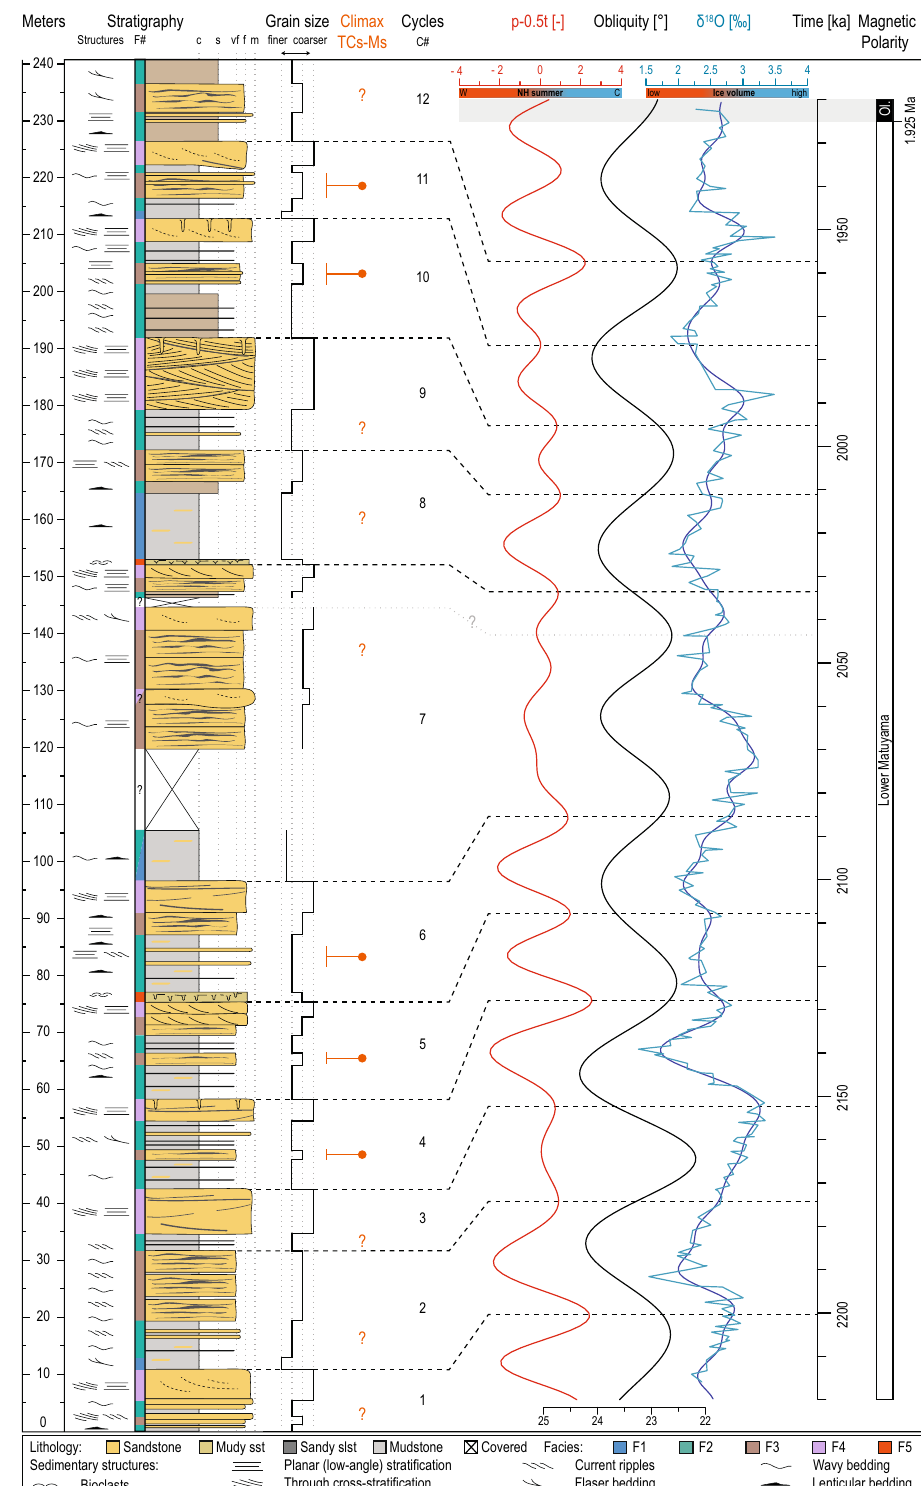
Facies: F3F1 F4F2 F5Lithology: Sandy slstSandstone Mudy sst Mudstone Covered Sedimentary structures: beddingWavy bedding beddingCurrent ripples cross-stratificationPlanar (low-angle) stratification Flaser Through Bioclasts Lenticular Figure 3. Stratigraphy and chronology of the lower Cholan Fm along the Houlong River. The stratigraphic data (facies, lithology, grain size) are compared and correlated to: (1) a mix-standardized precession minus 0.5 times standardized obliquity (p-0.5t) 39 as orbital reference based on the Laskar, et al. 7 solution (red curve), (2) pure obliquity curve (black curve) 7 , and (3) a δ 18 O record from benthic foraminifera (light blue curve) 40 smoothed (dark blue curve) using a Taner 41 low-pass filter with a cutoff frequency of 0.1 and a roll-off rate of 10^10 using the ‘astrochron’ R package 42,43 . Climax periods of tropical cyclone and monsoon are pointed out by orange dots or orange “?”. W: warmer, C: colder. The illustration was made using Adobe Illustrator CS6 (https:// www. adobe.